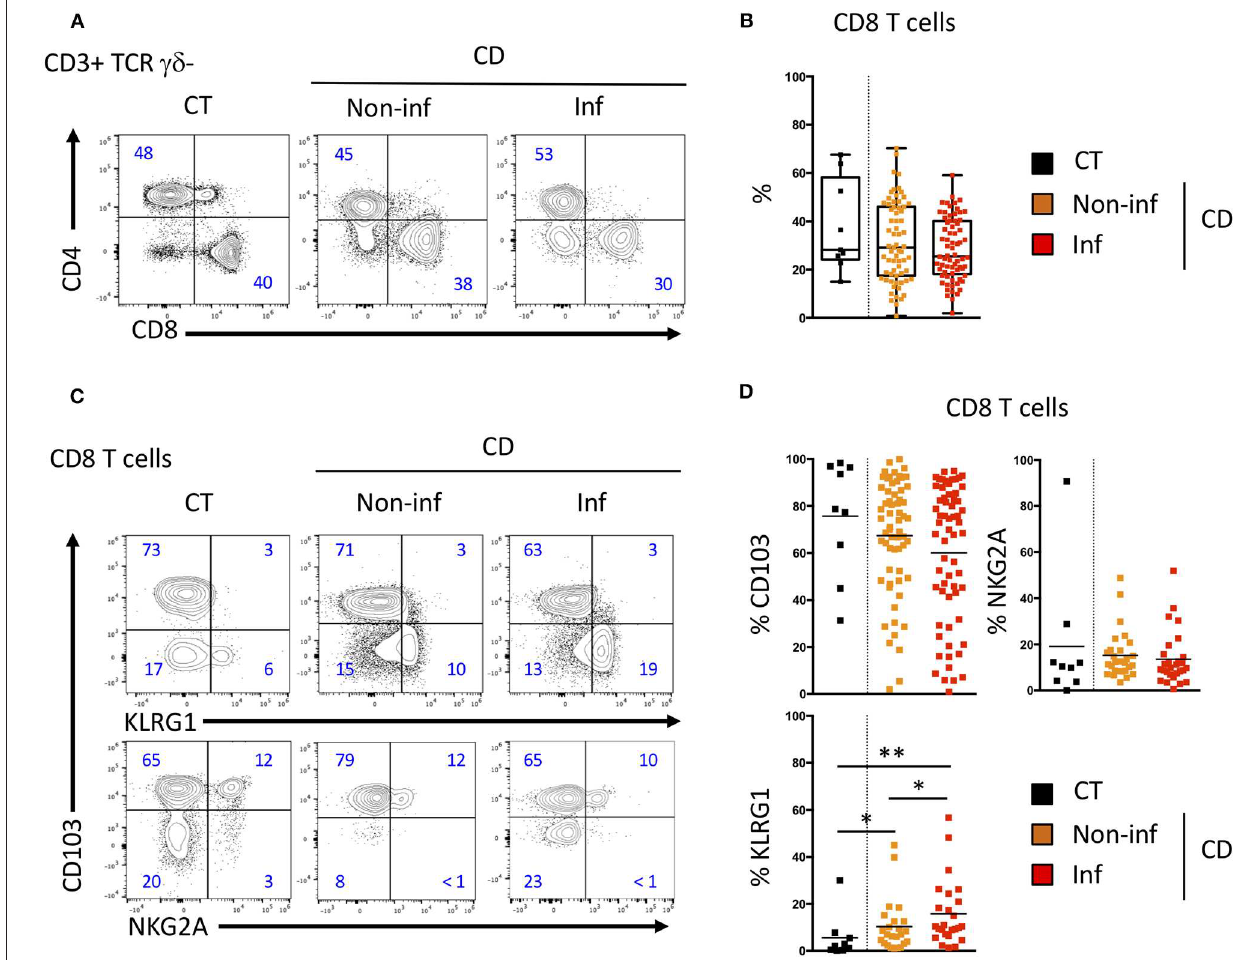
FIGURE 4 | CD103 and KLRG1 CD8 Trm cell subsets in ileal Crohn’s disease. (A) Representative CD4 and CD8T cells staining and (B) quantification in the ileal mucosa of control individuals (CT; n = 10), CD patients in macroscopically inflamed (lnf) and non-inflamed (non-inf) segments of the ileocecal resections ( n = 69; boxes represent median and range; unpaired t -test: not significant). (C) Representative expression and (D) quantification of CD103 ( n = 69), KLRG1 ( n = 25), and NKG2A ( n = 35) on CD8T cells from ileal mucosa as in A (bars represent means; unpaired t -test between CT and CD; paired t -test between lnf and Non-lnf: * p < 0.05, ** p <